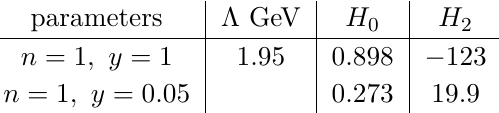
Table 3 . The values of the parameters, used in the calculations of the finite-volume spectrum. For this reason, only to carry out the check, we use lower values of the cutoff Λ = 0 . 25